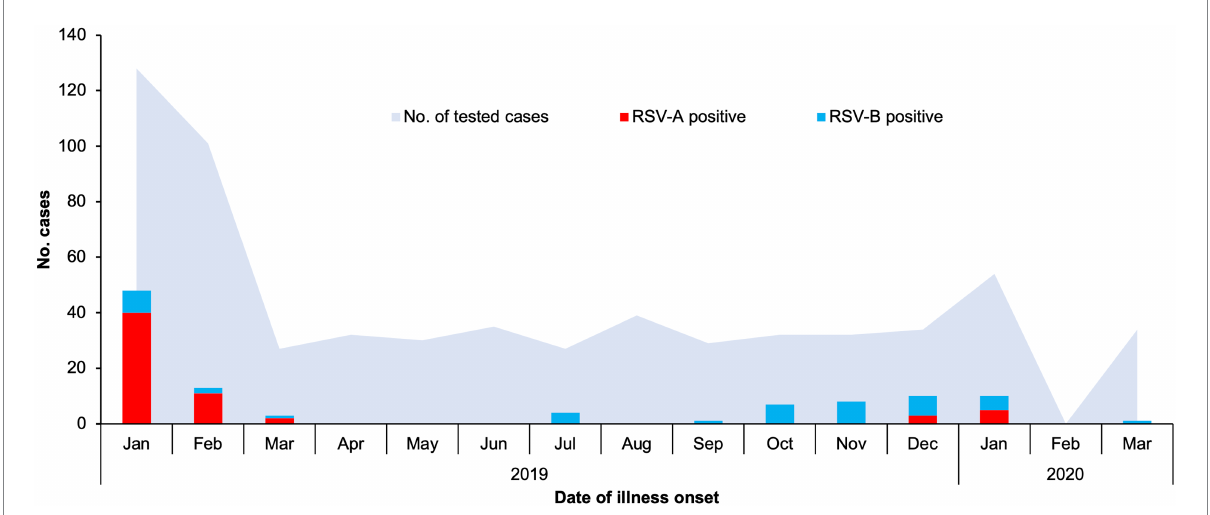
FIGURE 1 Respiratory syncytial virus A (RSV-A) and RSV-B infections in children admitted to Shanghai Children’s Hospital with respiratory tract infections, January 2019–March 2020. Hospitalized patients meeting the criteria detailed in the section “Materials and Methods” of the main text were enrolled, and lower respiratory tract aspirates were collected and used for detection of common respiratory tract infection pathogens. Numbers of RSV-A-positive, RSV-B-positive, and all tested cases are plotted against date of illness